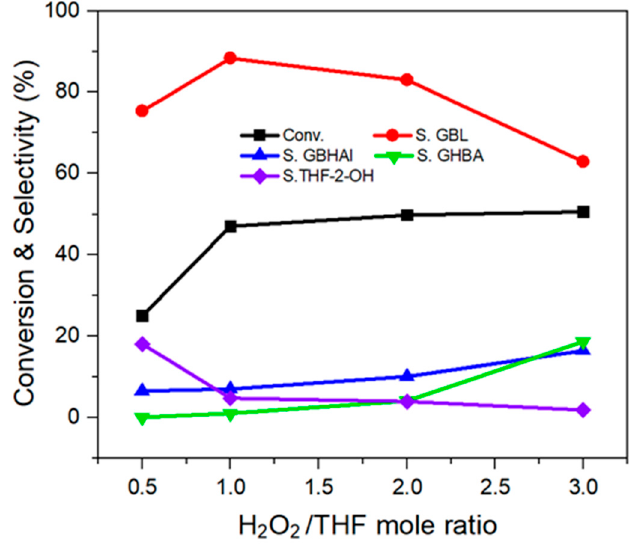
Figure 10. Effect of H 2 O 2 /THF mole ratio on the conversion and selectivity for the oxidation of THF. Reaction conditions: THF = 0.1 mol, 80 °C, 0.5 g of catalyst, and 9 h.